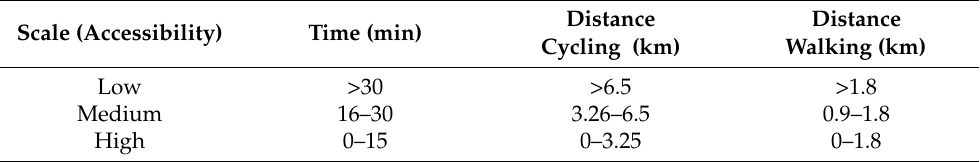
Table 7. Standardized rating